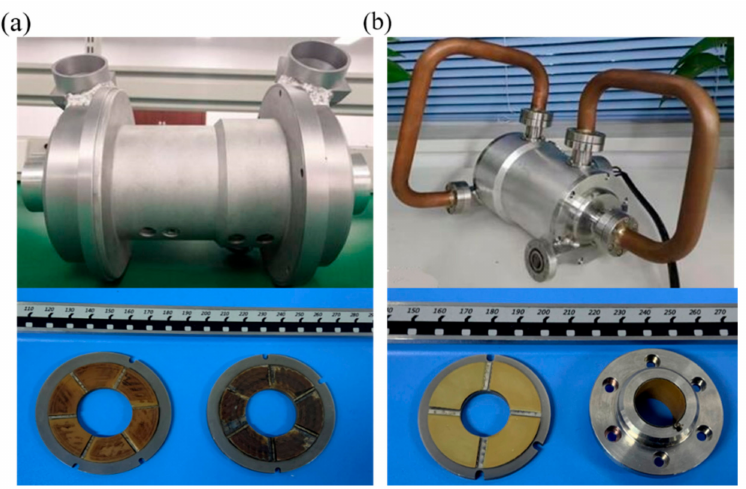
Figure 8. High-speed compressors and gas bearings by Xi’an Jiaotong University ( a ) air compressor; ( b ) refrigerant